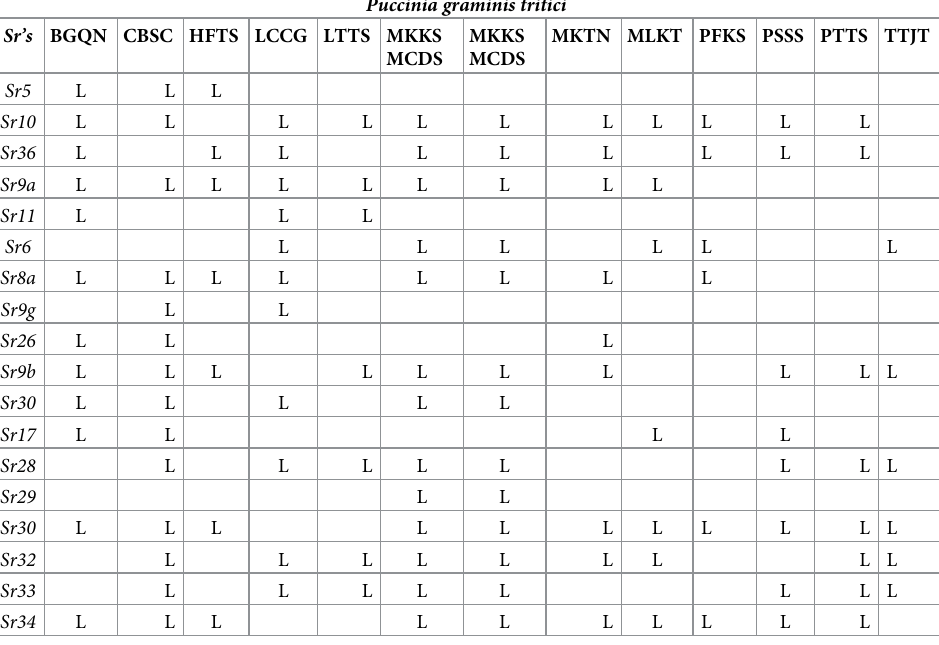
L = low infection type, Blank: High infection